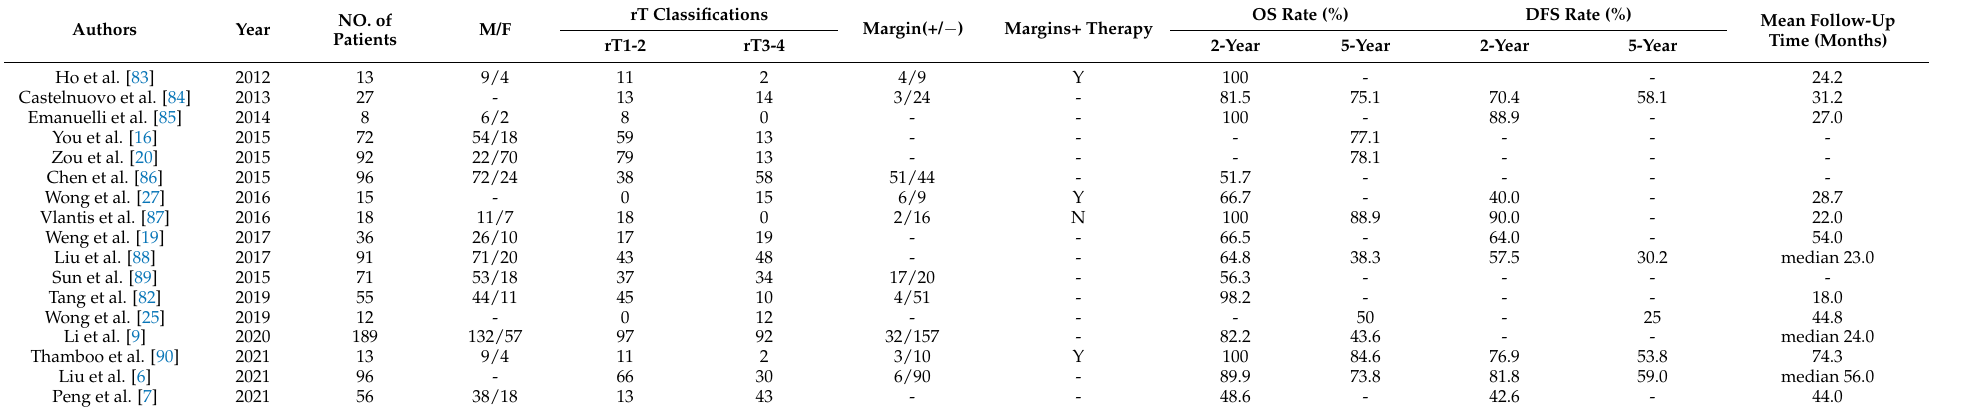
Table 2. Characteristics of the literature on EEN for recurrent NPC in the last 10